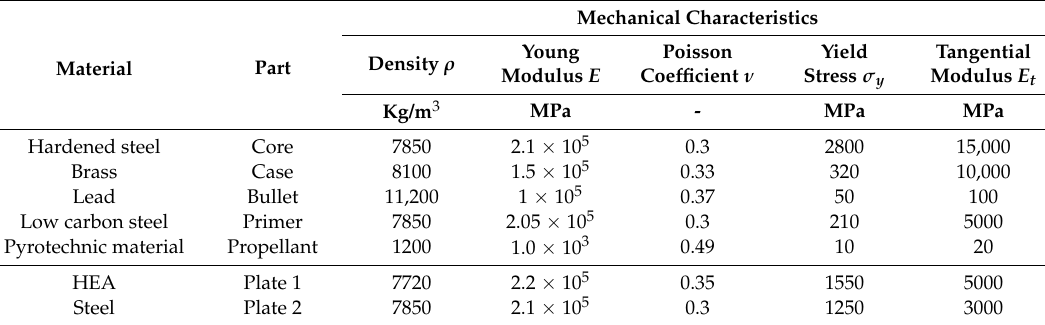
Table 2. Bi-linear elasto-plastic models.